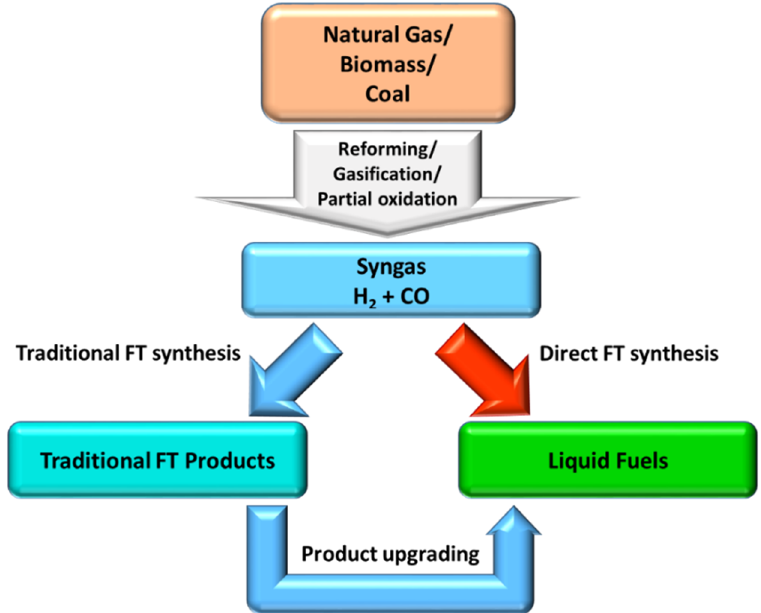
Figure 1. Transformation of carbonaceous resources (natural gas, biomass, and coal) into liquid